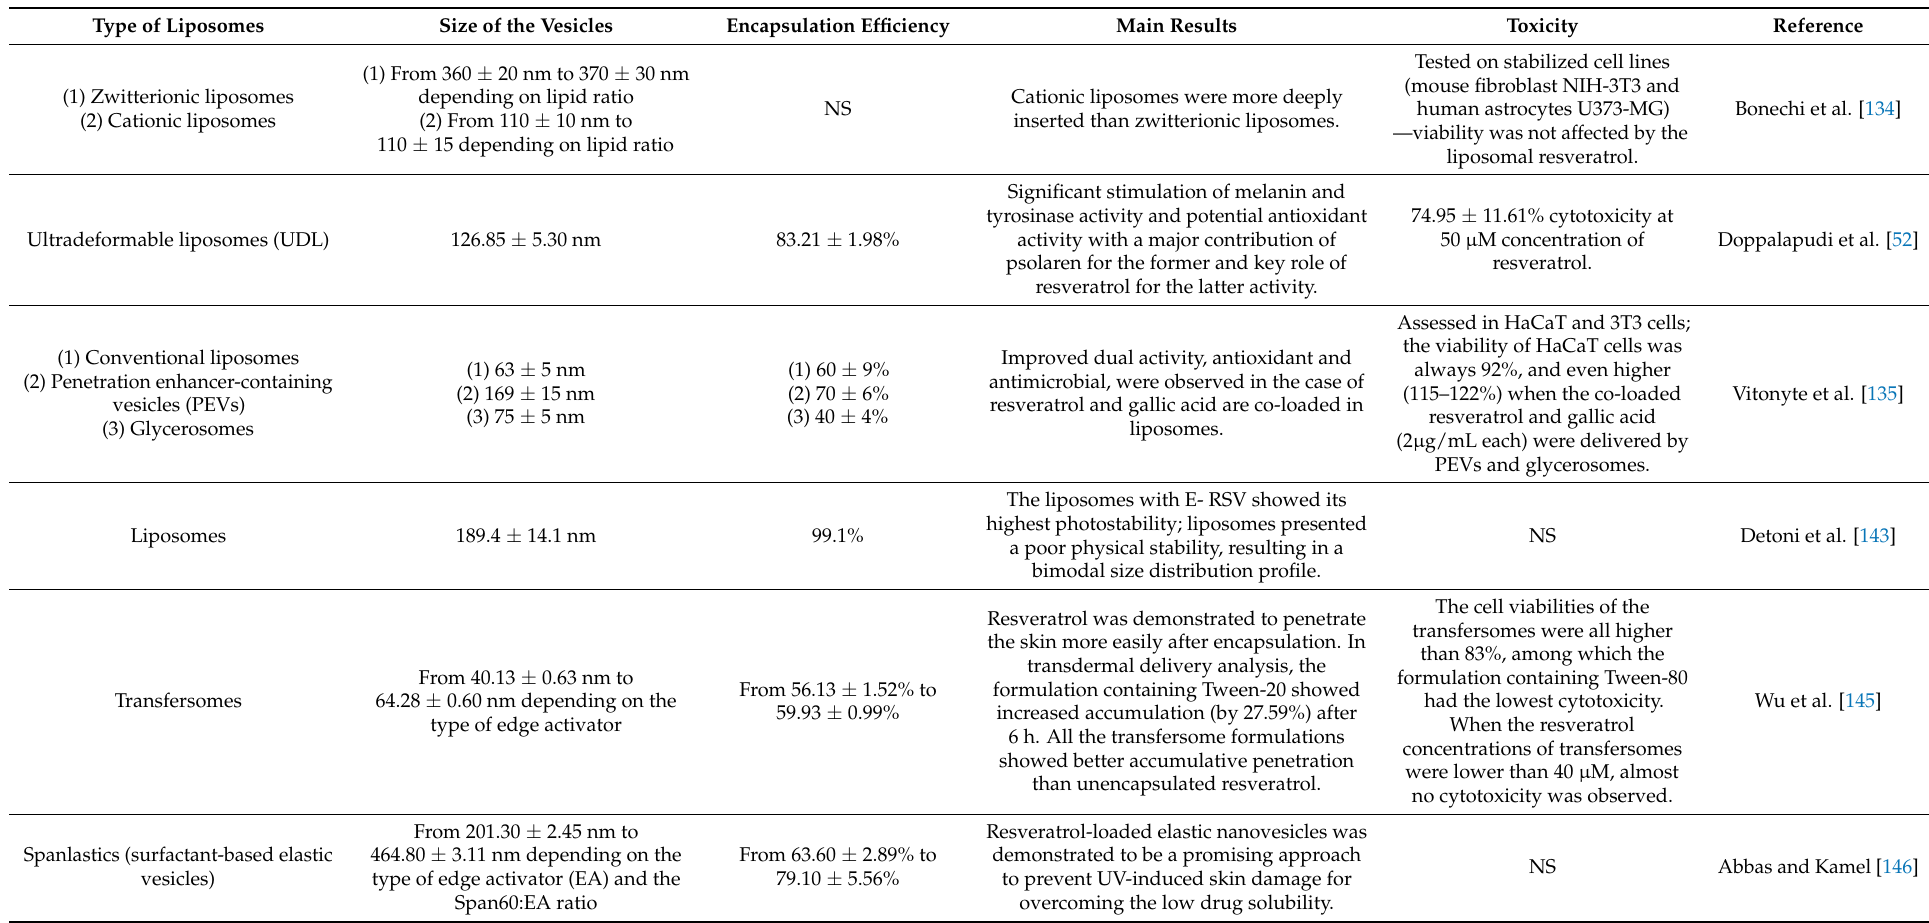
Table 3. Data on the topical use of different types of liposomes with